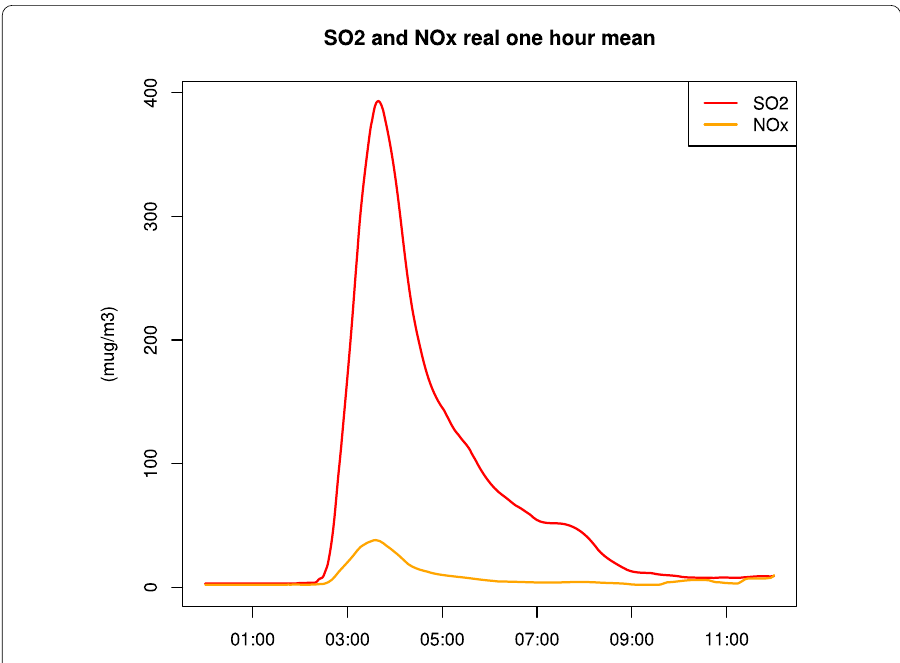
Figure 1 Episode depicted in one of sampling stations. The one hour mean of SO 2 and NO x are, respectively, drawn in red and orange